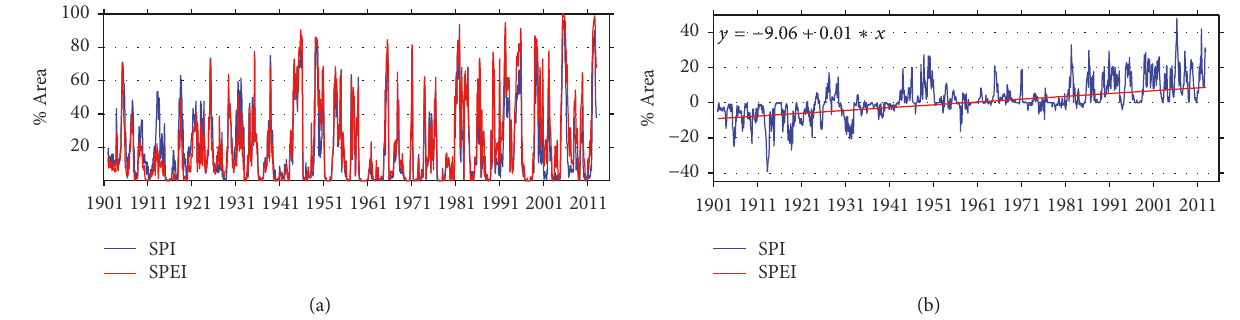
Figure 5: Percentage of monthly area affected by moderate drought (index < − 0.84), computed with SPEI and SPI (a), and the difference between the two